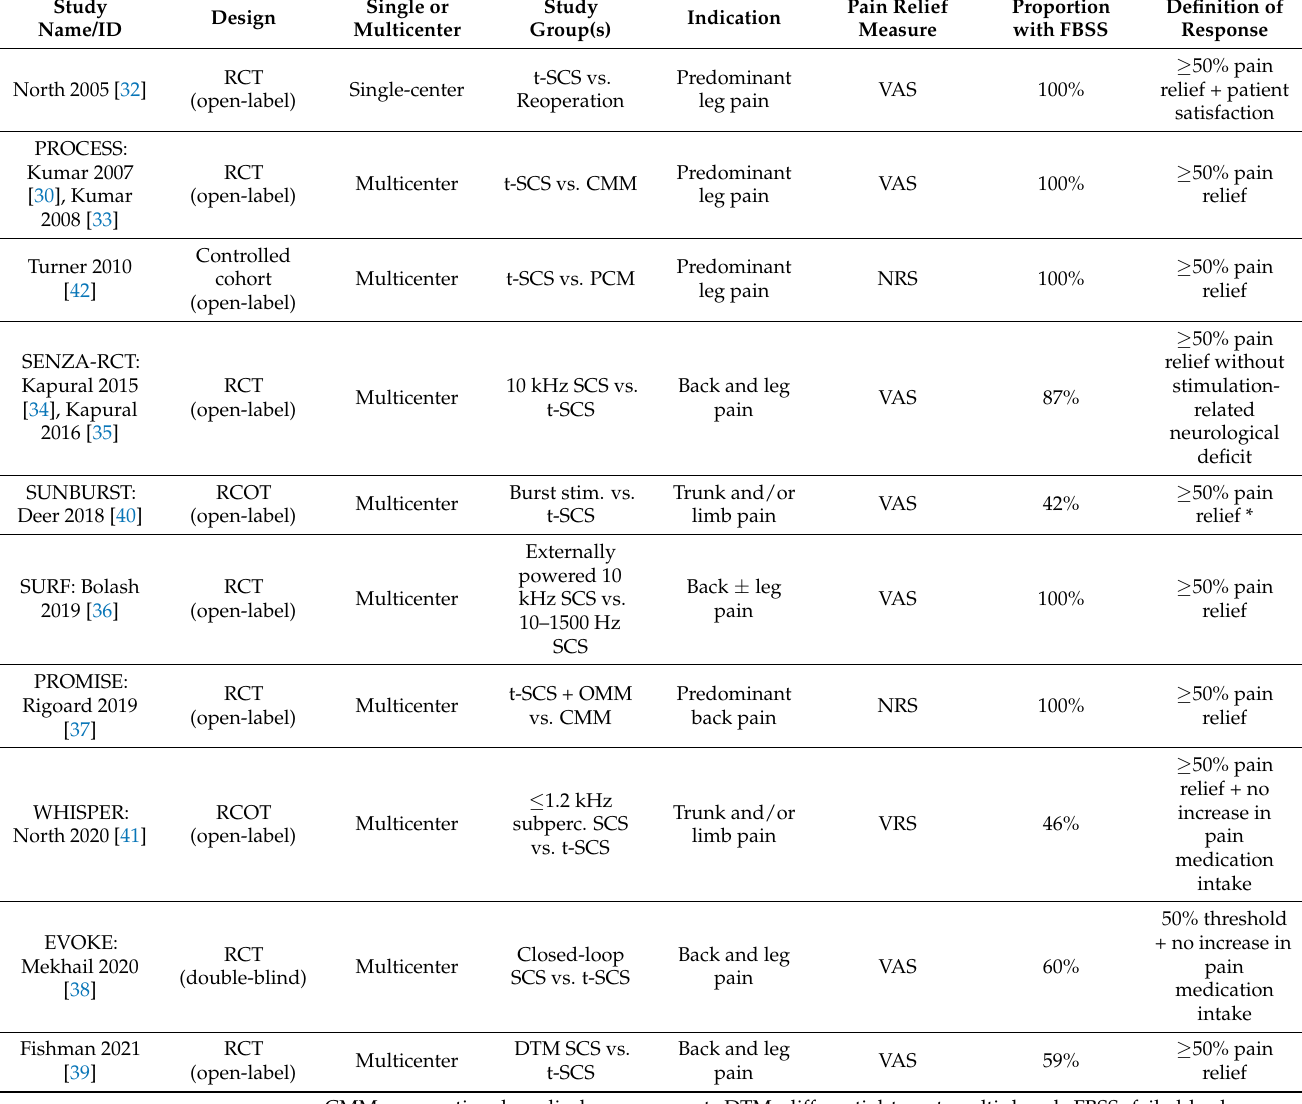
Table 1. Characteristics of included controlled